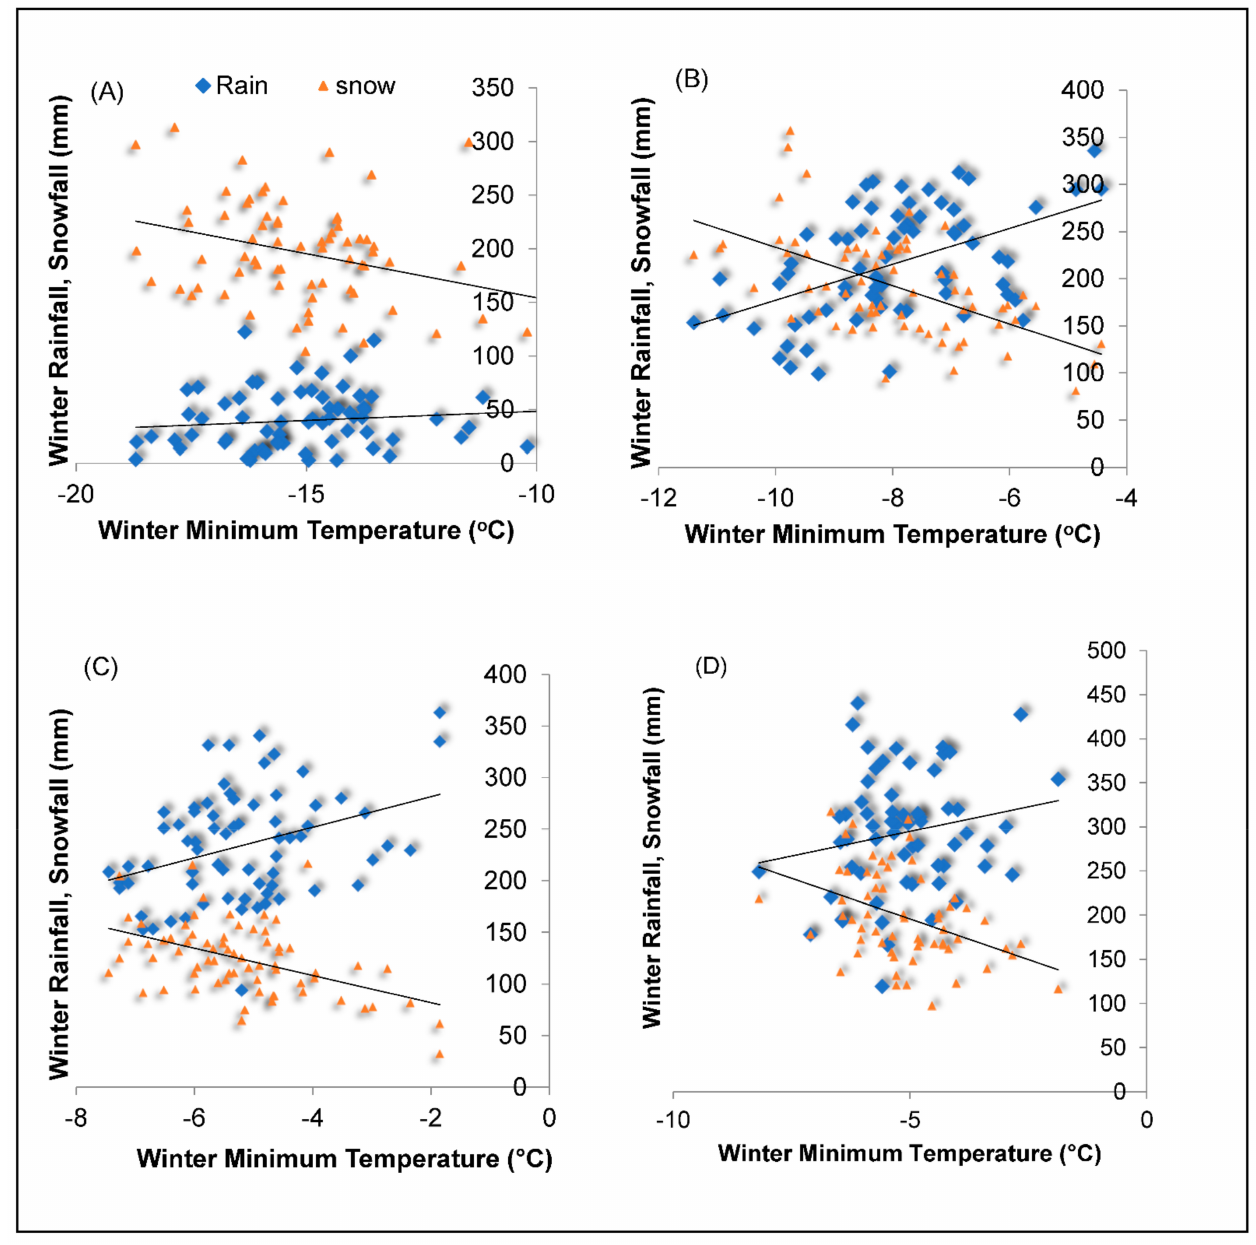
Figure 4. Time series plot of winter rainfall, winter snowfall versus minimum temperature at Sioux Lookout ( A ), Ottawa ( B ), Toronto ( C ) and London ( D ),